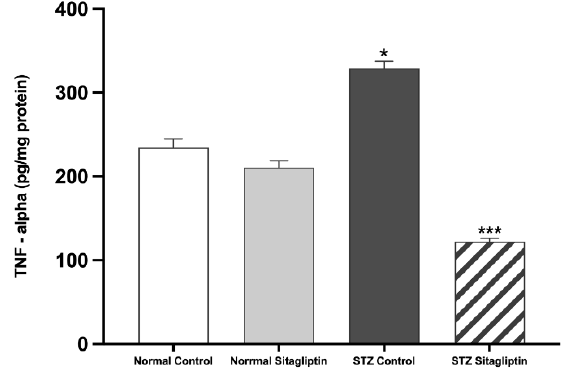
Figure 3. Effects of sitagliptin on plasma tumor necrosis factor-alpha (TNF-α) levels in STZ-induced diabetic rats. Data are expressed as means ± SEM, according to one-way ANOVA followed by the Bonferroni test ( n = 6 animals per group). * p < 0.05 vs. normal control (non-diabetic control); *** p < 0.001 vs. STZ control group; STZ, streptozotocin.